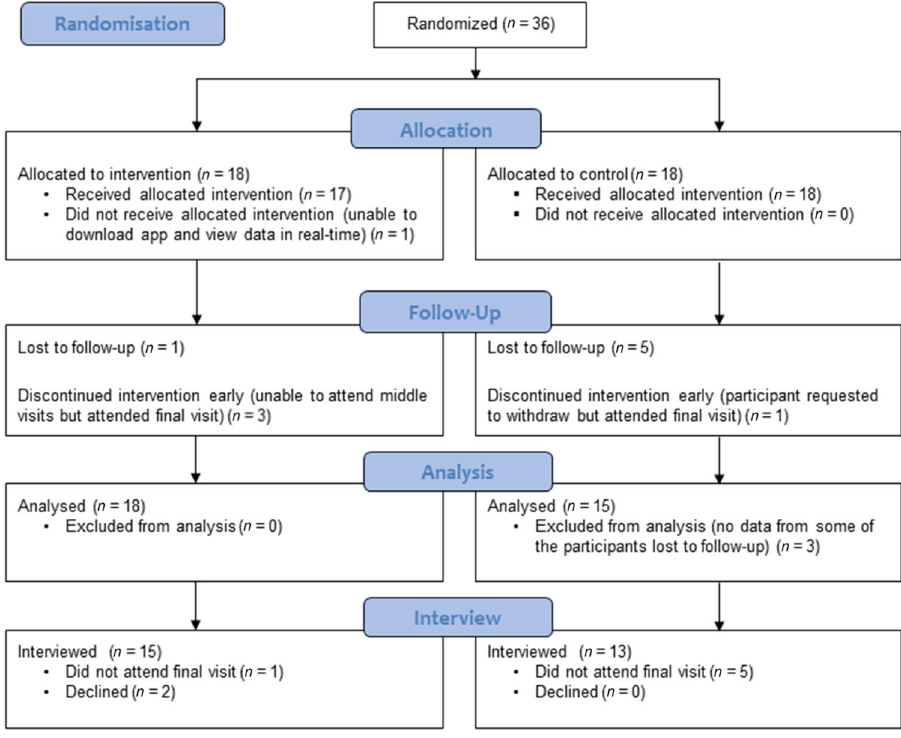
Fig. 1 Flow diagram. Flow diagram for interview recruitment where n represents the number of participants.